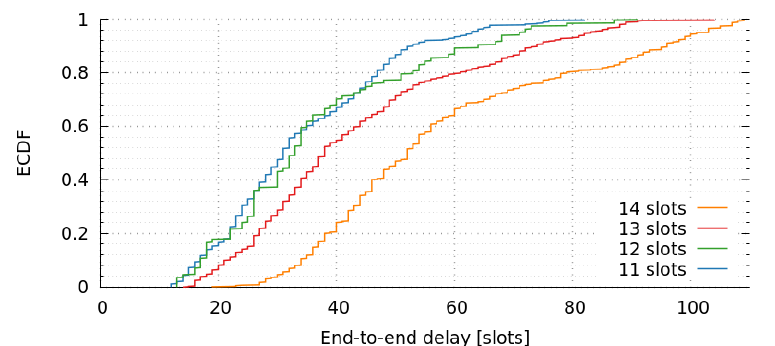
Figure 11. End-to-end message delays for various